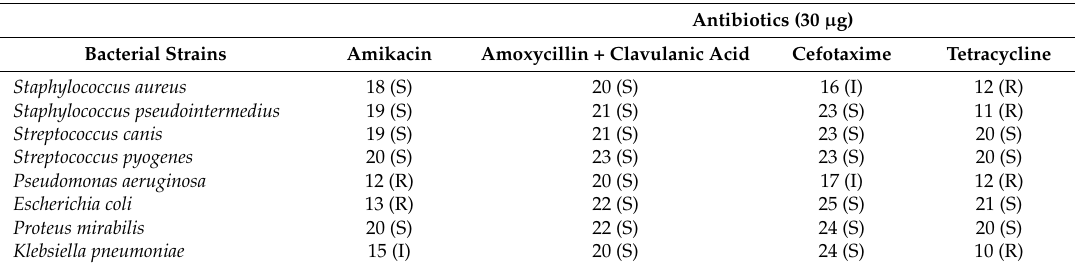
Table 2. Results (inhibition zone expressed in mm) of the Kirby-Bauer assay testing the selected bacterial strains against four